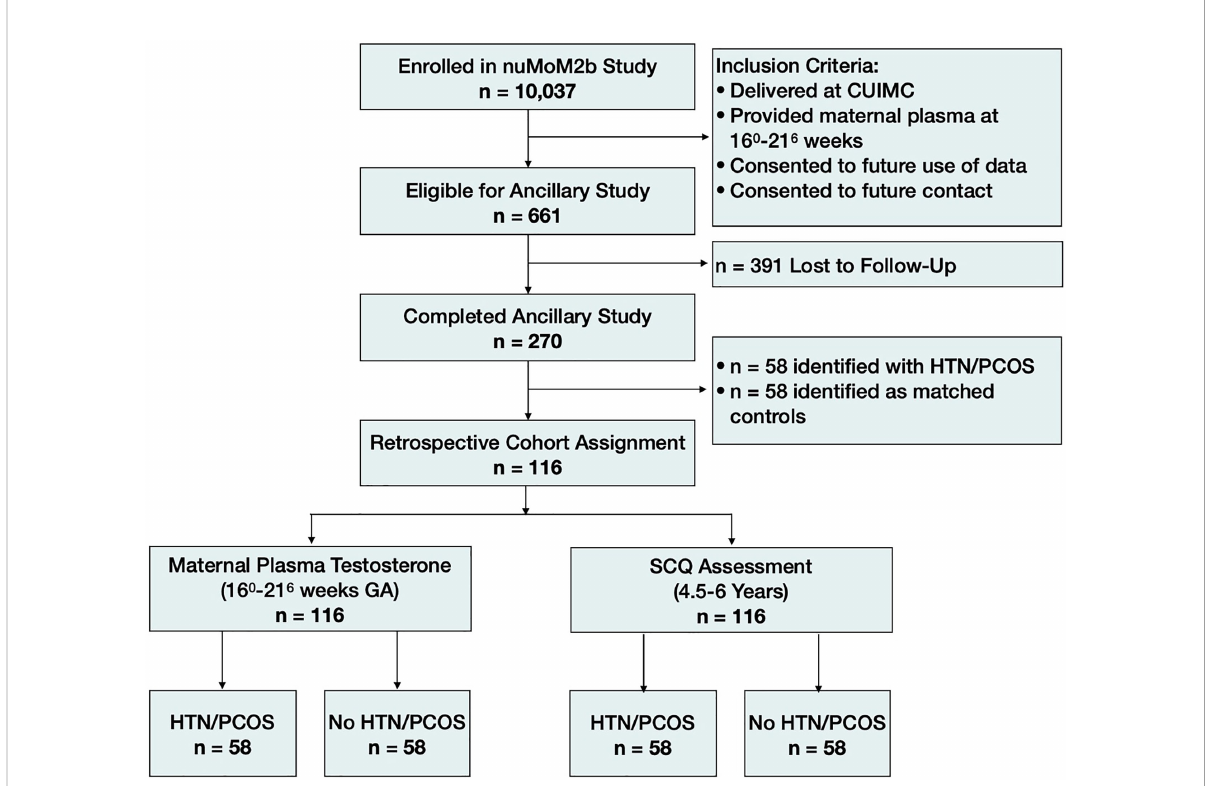
FIGURE 1 Cohort diagram. HTN/PCOS, Hypertensive disorder of pregnancy and/or polycystic ovary syndrome; SCQ, Social Communication